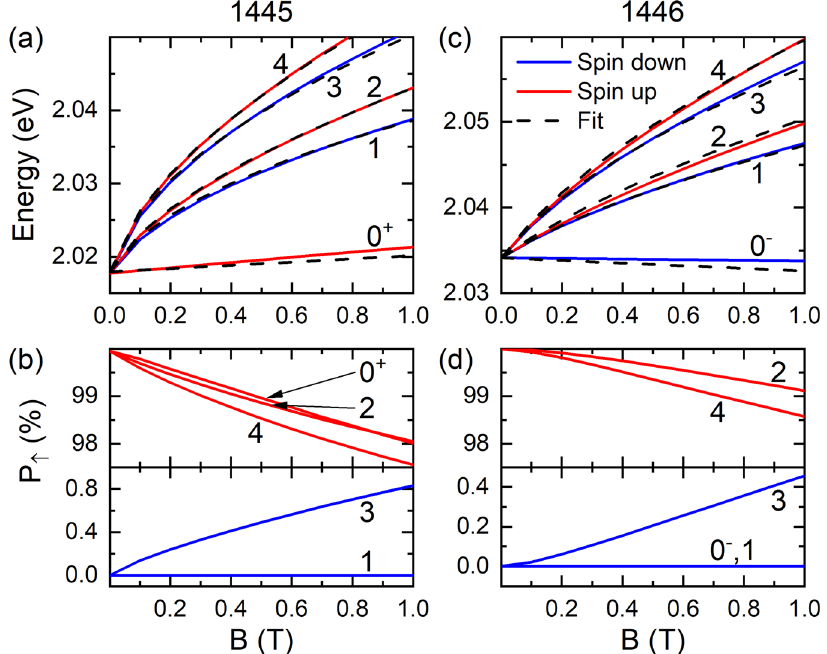
Fig.4|Spin-polarizedLLs.a Thecalculatedlow-lyingLLsfromthe k ⋅ p model(solid lines)forsample1445and fi twiththefour-bandmodel(dashlines)atlowmagnetic fi elds. The red and blue colors correspond to the spin-up and down LLs,